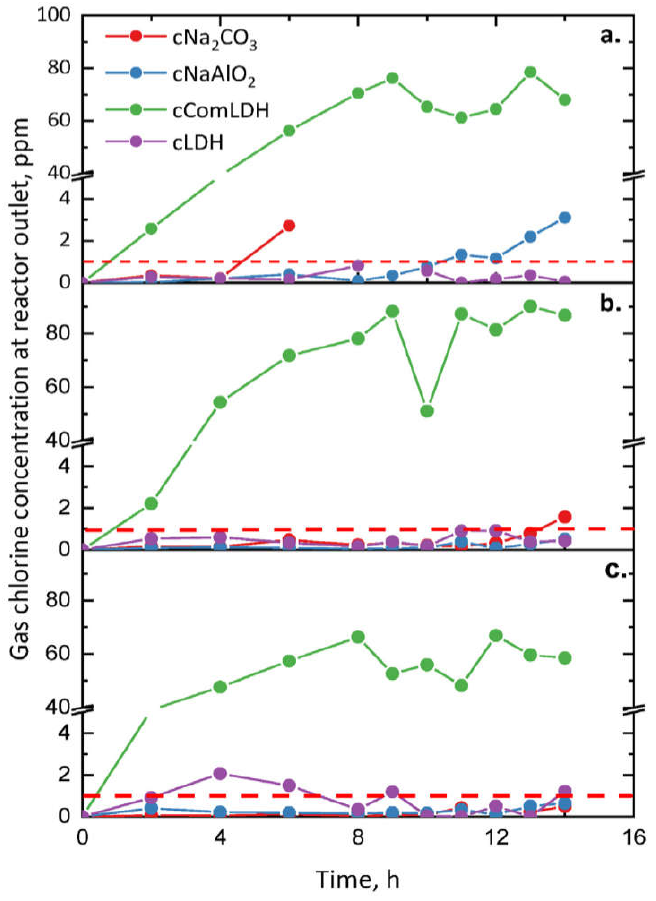
Figure 6. Concentration of HCl in the effluent at 400 ( a ), 500 ( b ), and 600 °C( c ) for each sorbent. (The horizontal red dashed line represents the 1 ppm breakthrough threshold) [109].